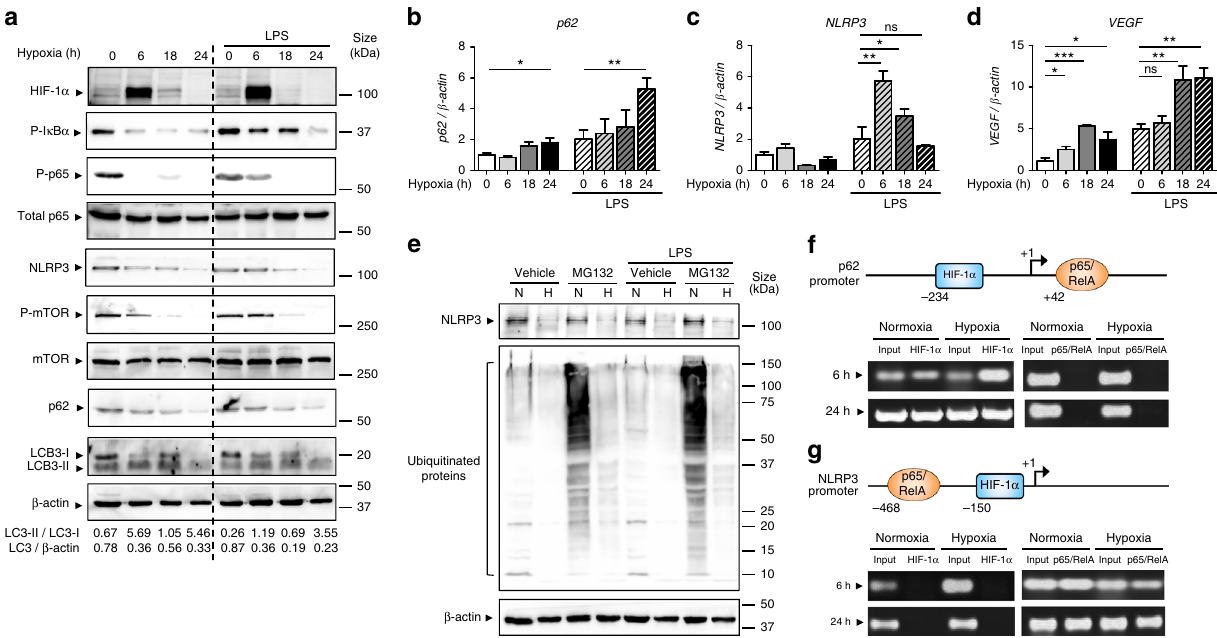
Fig. 4 Hypoxia reduces in fl ammatory signaling pathways and NLRP3 expression and induces autophagy in IECs. a HT-29 cells were subjected to normoxia and hypoxia at the indicated times in the absence or presence of 10 µ g/ml LPS. Autophagy was measured by variations in the ratio of LC3-II/LC3-I and the total amount of LC3 (LC3-I plus LC3-II) relative to β -actin. Results are representative of two independent experiments. b , c and d HT-29 cells were subjected to normoxia and hypoxia for the indicated periods in the absence or presence of 10 µ g/ml LPS, followed by transcript analysis. Statistical analysis was performed using one-way ANOVA followed by Tukey ’ s post-test. Results represent mean + s.e.m. of two independent experiments done in triplicate, * P < 0.05; ** P < 0.01; *** P < 0.001; ns not signi fi cant. e HT-29 cells were subjected to normoxia or hypoxia in the presence and absence of 10 µ g/ ml LPS and 20 µ M of MG132. Results are representative of two independent experiments. f and g Putative binding sites for HIF-1 α and NF- κ B were found in the p62 f and NLRP3 g promoters using Genomatix software tools. Numbers under the boxes indicate the distance from the transcription start site. HT-29 cells were subjected to normoxia (21% O 2 ) or hypoxia (0.2% O 2 ) for 6 h and 24 h. ChIP analysis was performed using antibodies against HIF-1 α and NF- κ B for immunoprecipitation. PCR was performed using the promoter-speci fi c primers for the p62 f and NLRP3 g promoter binding sites of HIF-1 α and NF- κ B. Aliquots taken prior to immunoprecipitation were used as input control. PCR products were run on 2% agarose gel. The results are representative of three independent